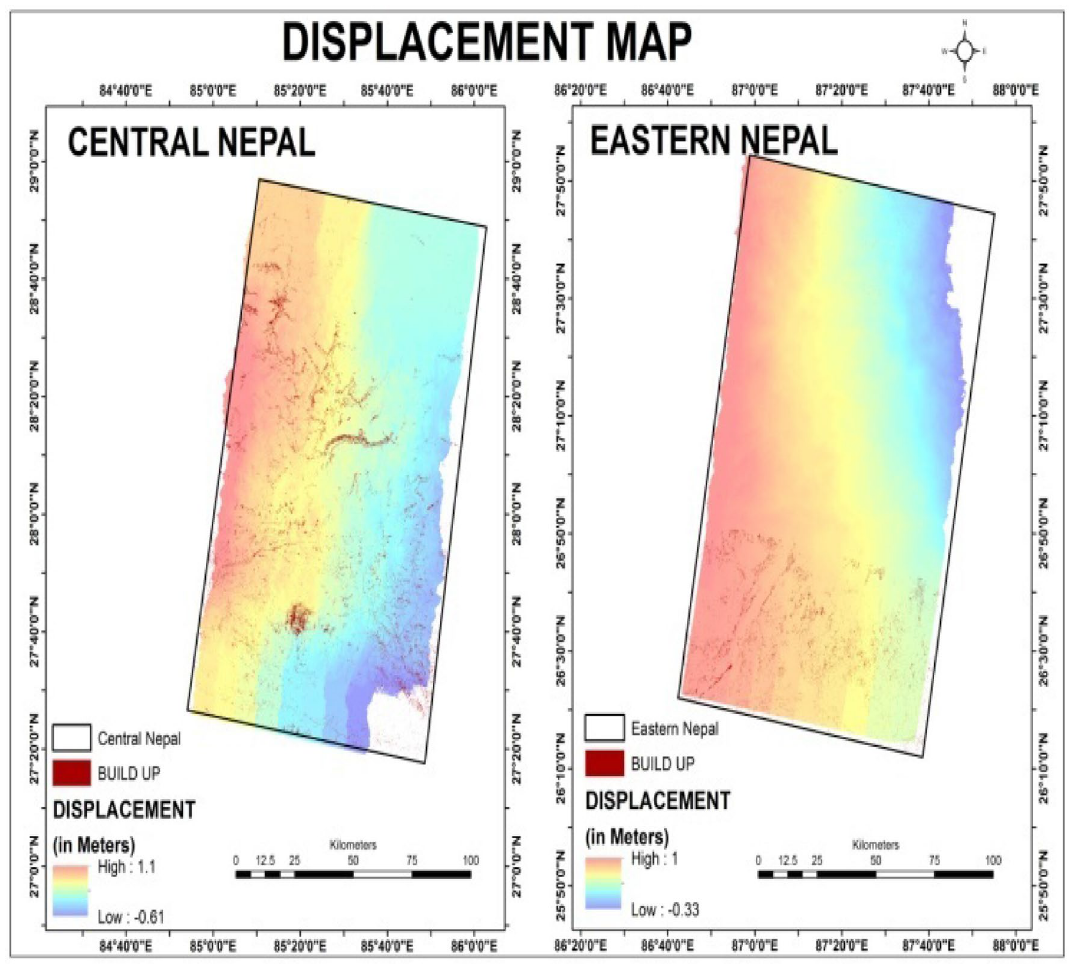
Fig. 7 Displacement Map of Central and Eastern